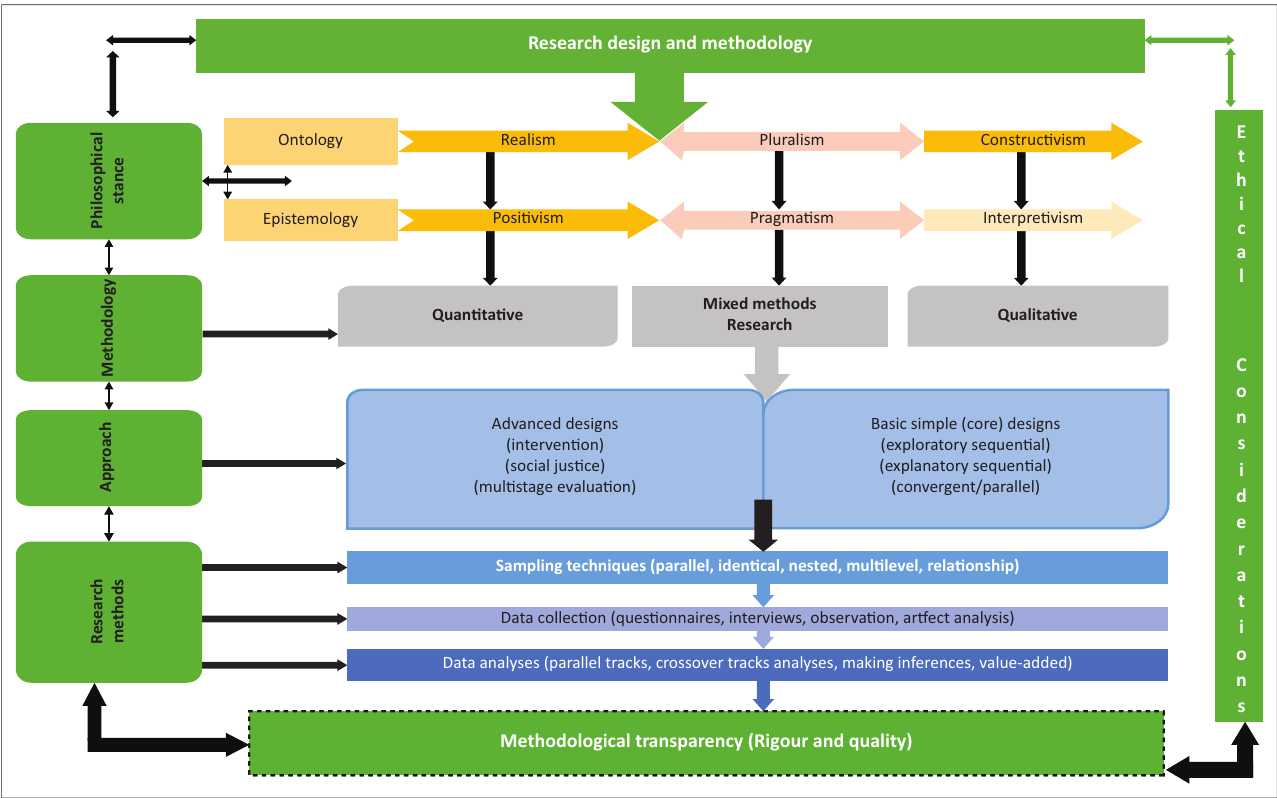
FIGURE 1: Main characteristics of mixed methods